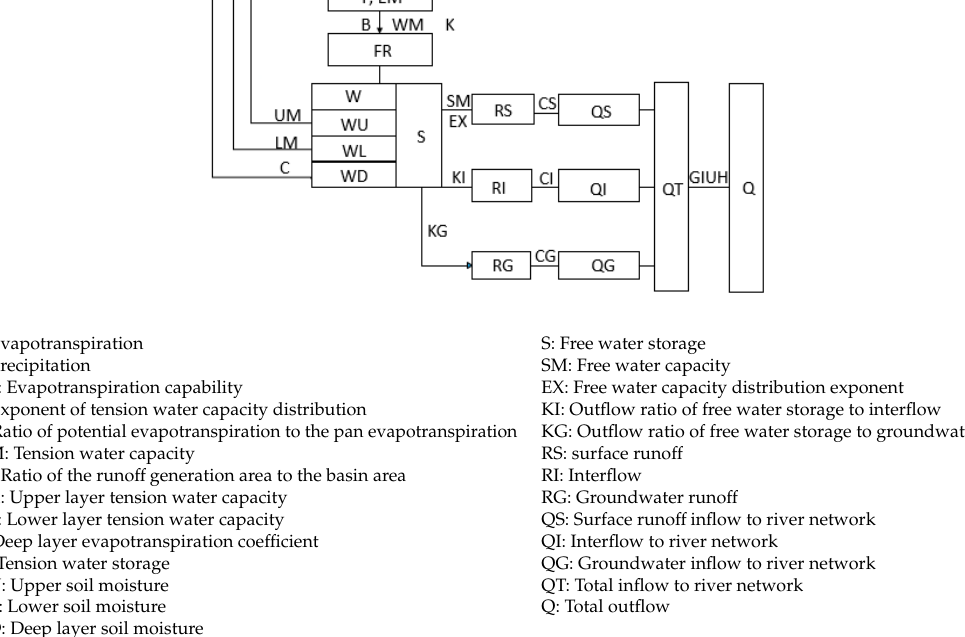
Figure 3. A diagrammatic sketch of the structure of “Free water reservoir” (with such a nonfigurative structure, the runoff generation can be partition based on the runoff components.).